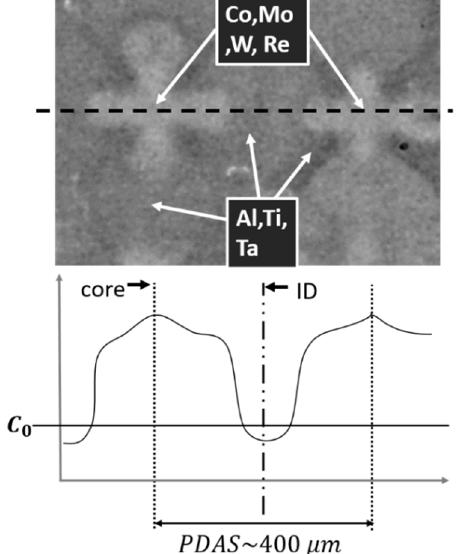
Figure 1. A micrograph of two dendrites from a directionally solidified CMSX-4 ® alloy, showing elemental microsegregation with heavy elements such as Co, Mo, W, and Re across the dendrite core and lighter elements, Al, Ti, and Ta, in the interdendritic regions (ID). The heavy and the light elements cause the contrast between the brighter and darker regions, respectively. An approximate primary dendrite arm spacing (PDAS) distance and nominal composition, C 0 , are shown for reference.